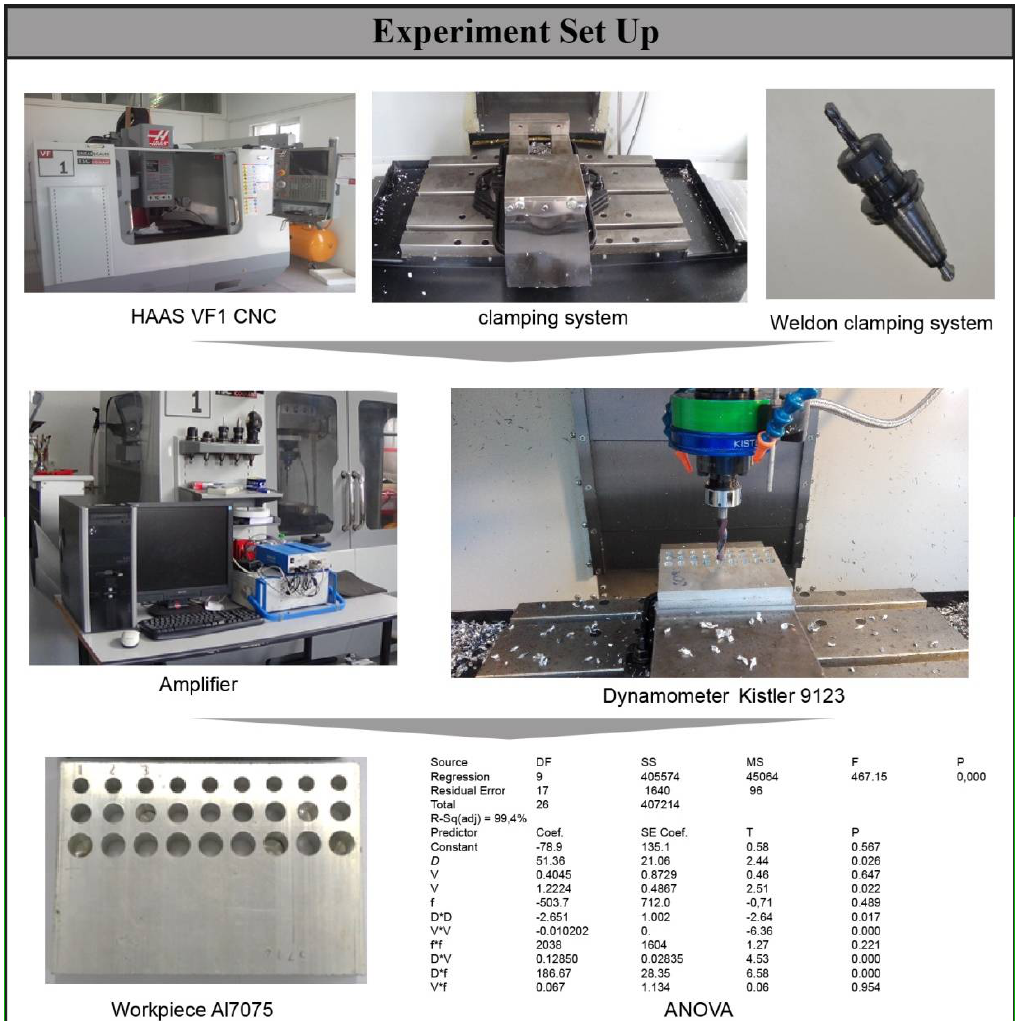
Figure 1. The workflow used for the research.